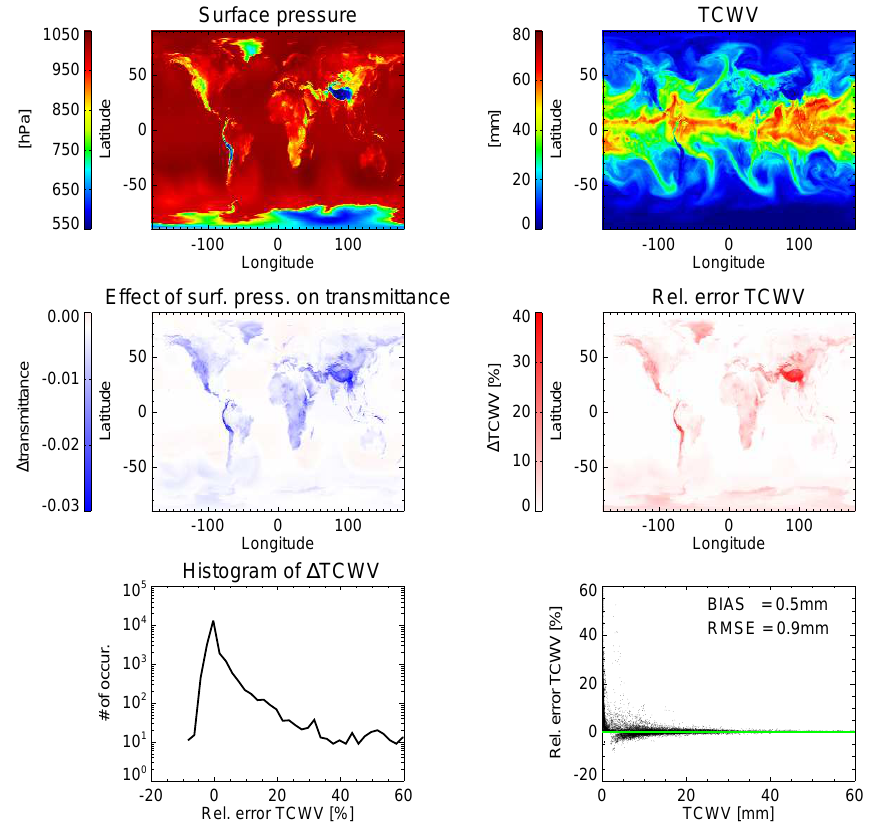
Fig. 2. Effect of surface pressure on TCWV retrieval: Top panels show surface pressure and TCWV on 2 June 2007, taken from GFS reanalysis. Middle panels show impact on transmittance and resulting relative error of derived TCWV, based on the assumption of a constant surface pressure of 1013hPa (for constant solar zenith angle of 45 ◦ and nadir view). Bottom panels show global histogram of relative error and its dependency on TCWV, shown only for land